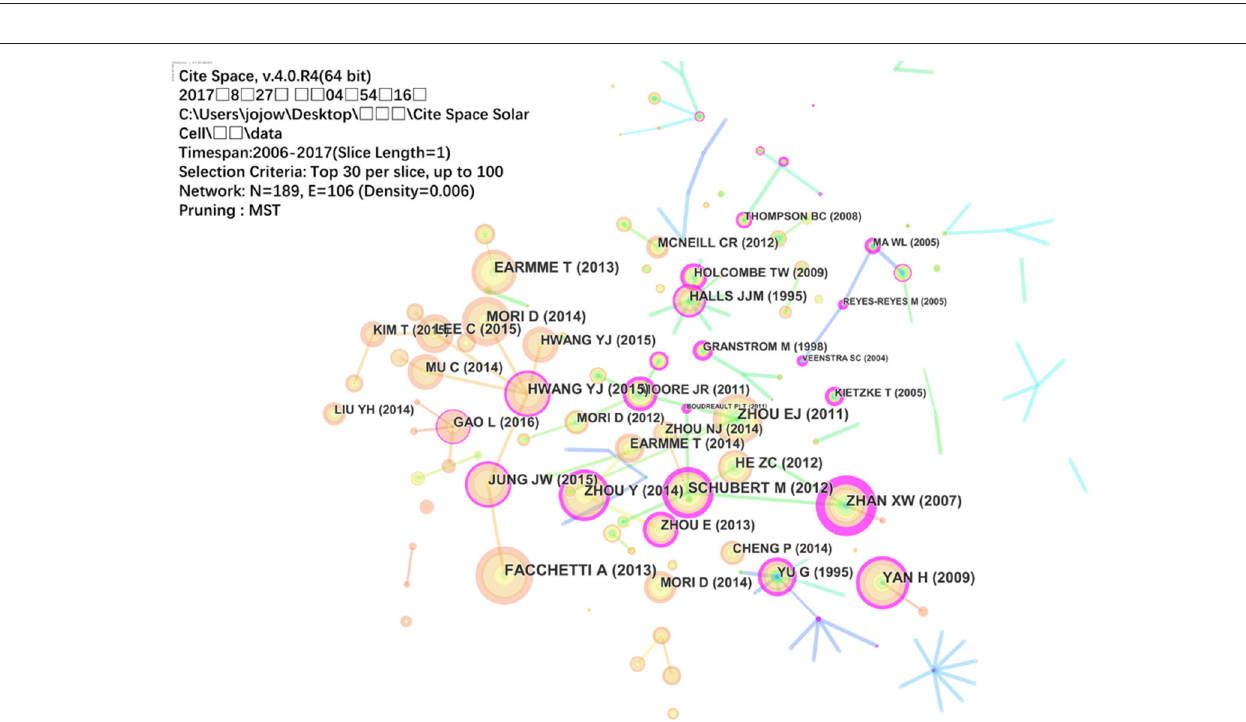
FIGURE 5 | Clusters visualization based on a document co-citation network of 2017.